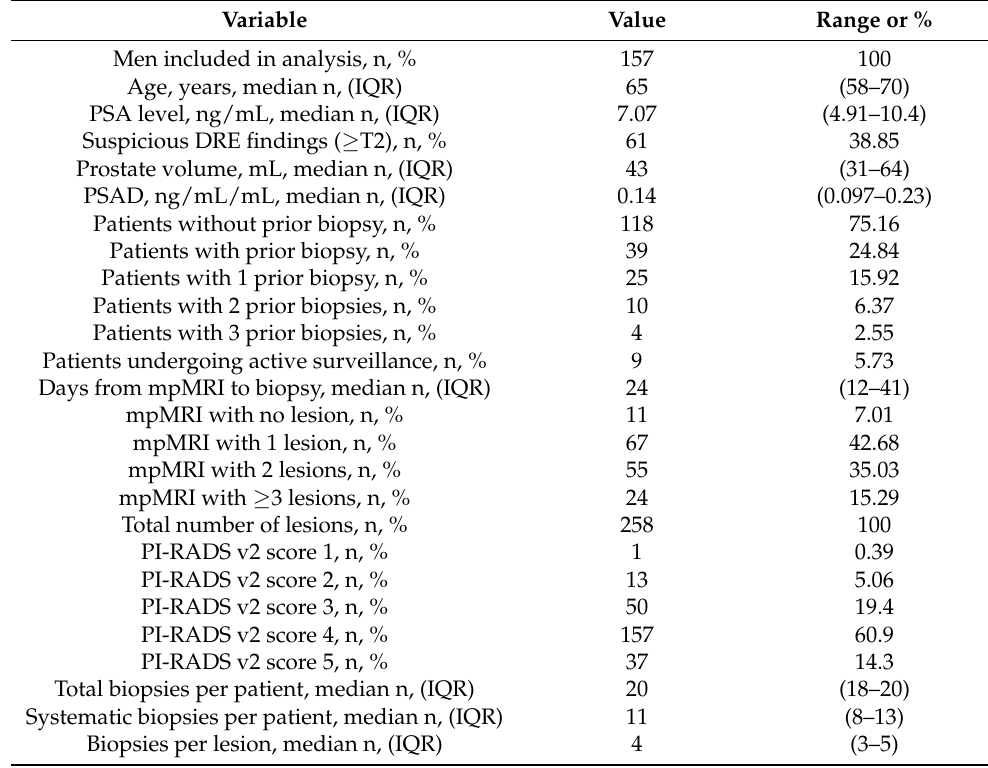
Table 1. Patients baseline